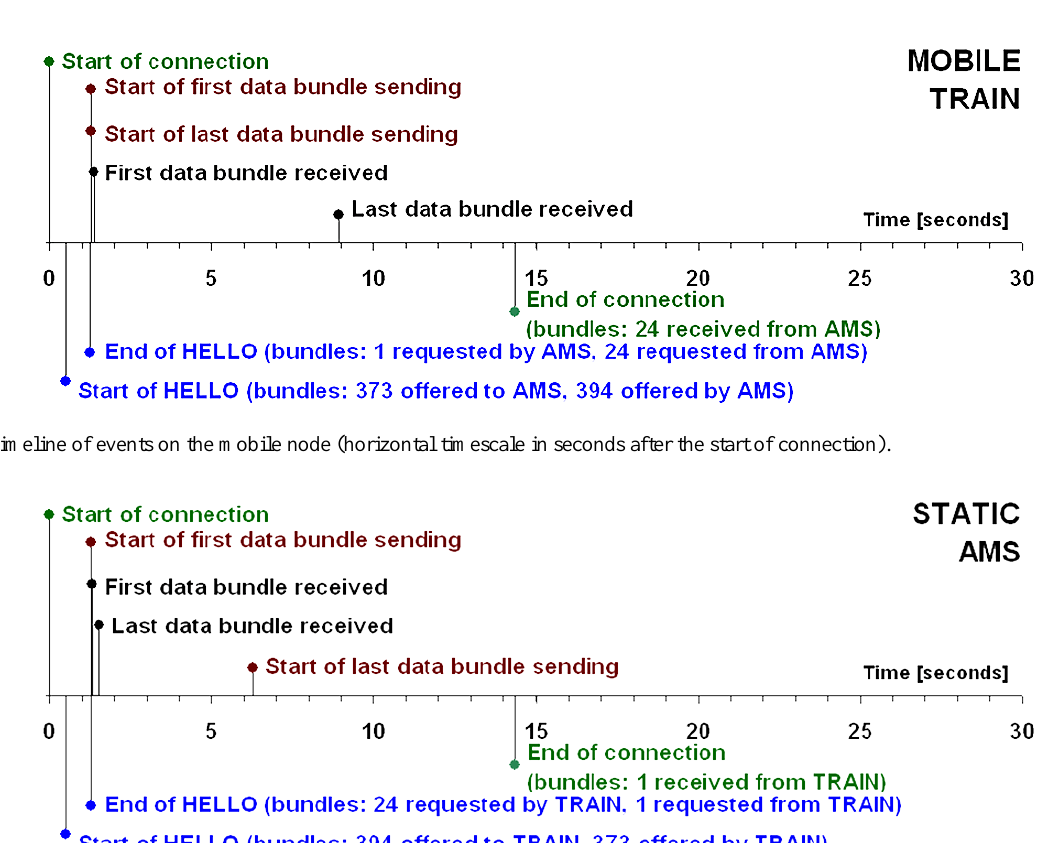
Fig. 12. Timeline of events on the static node (initiator of connection, timescale in horizontal in seconds after the start of connection).